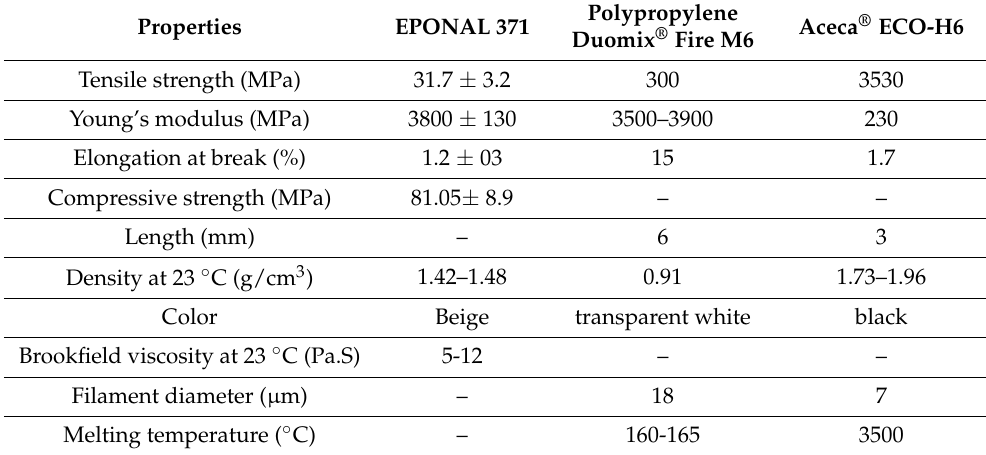
Table 1. Properties of used materials according to the